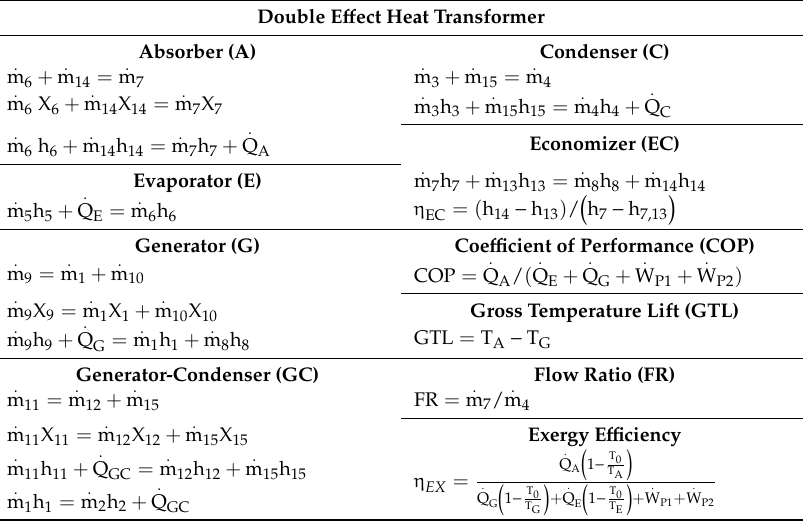
Table 1. Main equations for the double-e ff ect heat transformer (DEHT).